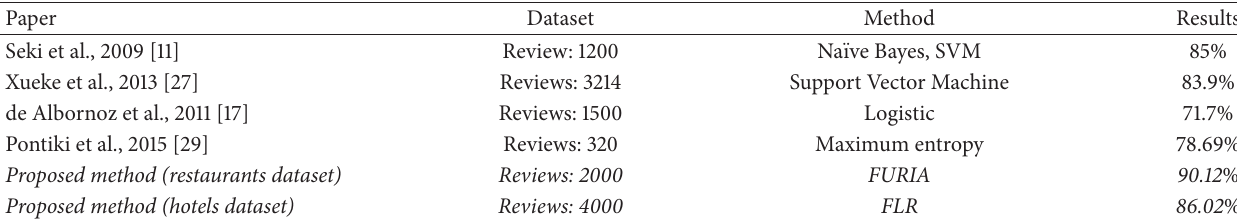
Table 5: Comparison with other aspects extraction